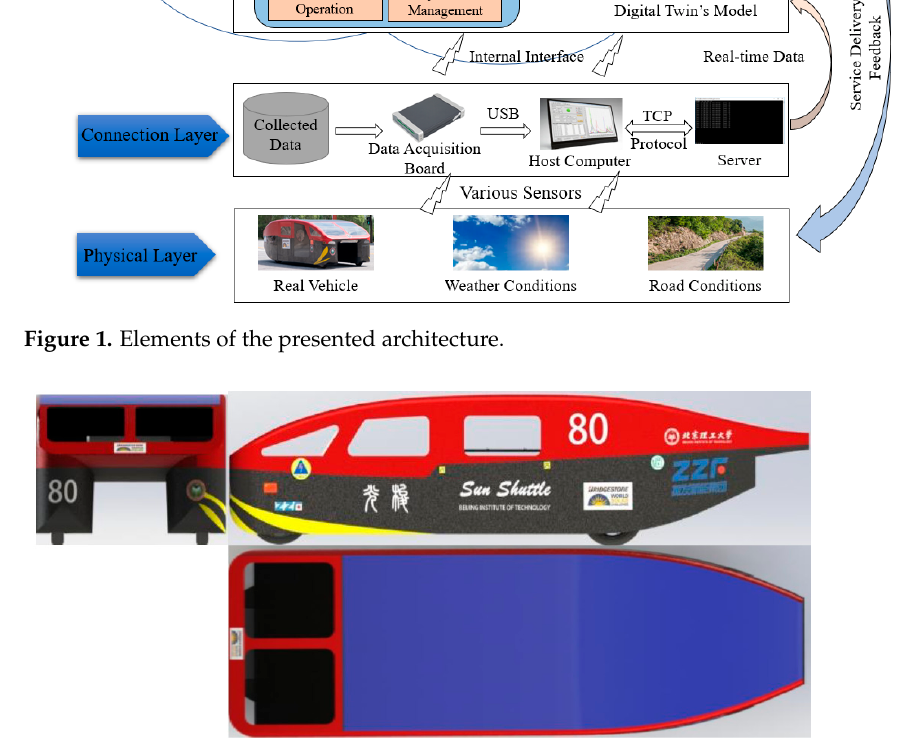
Figure 1. Elements of the presented architecture.